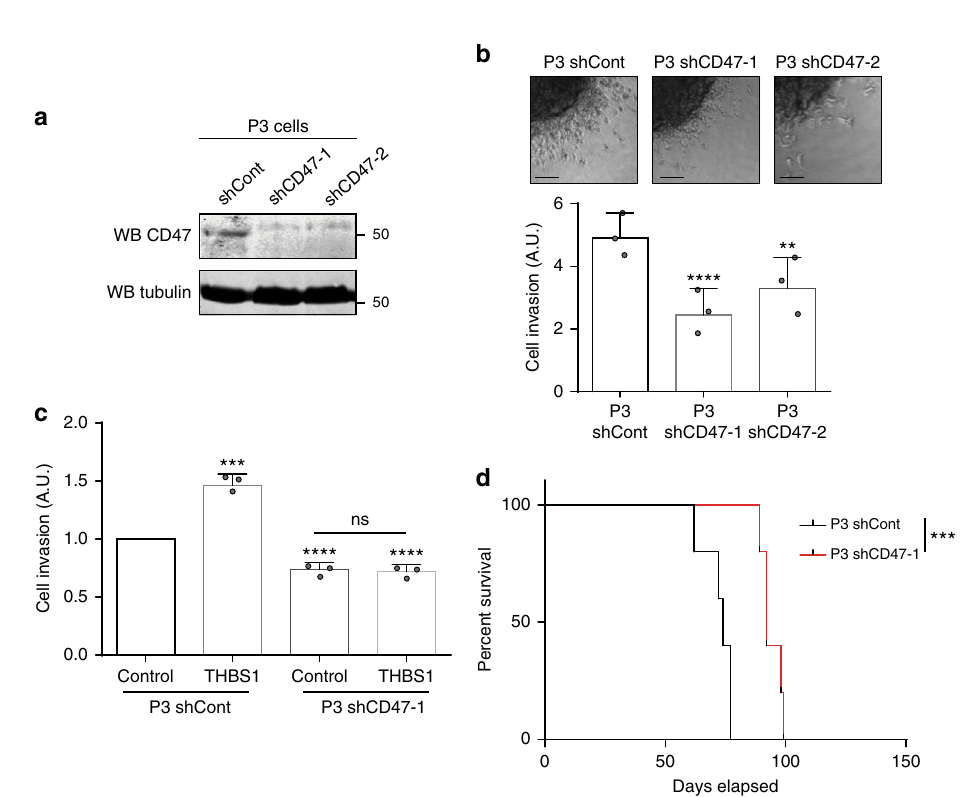
Fig. 6 Tumour-associated CD47 controls glioma cell invasion and motility. a Immunoblots of protein extracts from control or CD47-1/-2 shRNA- transduced P3 cells probed with anti-CD47 or anti-Tubulin antibodies. b P3 cells were transduced with control or CD47 ( − 1 and − 2) shRNAs. P3 spheroid invasion was measured in collagen I gels after 24 h. Scale: 50 µ m. The graph below represents the results as means ± s.d. of three independent experiments each done in 6 – 8 replicates for each condition. ** P < 0.01; **** P < 0.0001 (ANOVA). c Effect of THBS1 on P3 cells transduced with control or CD47-1 shRNAs. Full-length THBS1 was used at a concentration of 10 µ g/ml and invasion in collagen I gels was measured after 24 h. The results are expressed as means ± s.d. of three independent experiments each done in 6 – 8 replicates for each condition. ** P < 0.01; **** P < 0.0001; ns, non-signi fi cant (ANOVA). d Kaplan – Meier survival curves of mice bearing control or CD47-1 shRNA-transduced P3 tumours ( n = 5 mice per group); P -values were calculated with log-rank test; *** P -value <